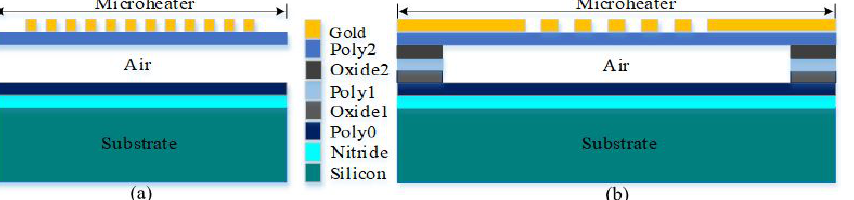
Figure 2. The PolyMUMPs process’s schematic of ( a ) the cross-section along AA’ view of the center plate and ( b ) the cross-section along BB’